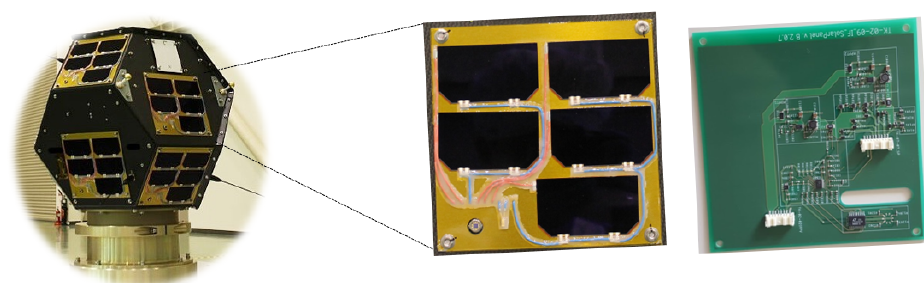
Figure 1. Solar Module Integrated Converter applied to Ten-Koh satellite: external view with solar cells and internal view where PCB with solar array regulator is